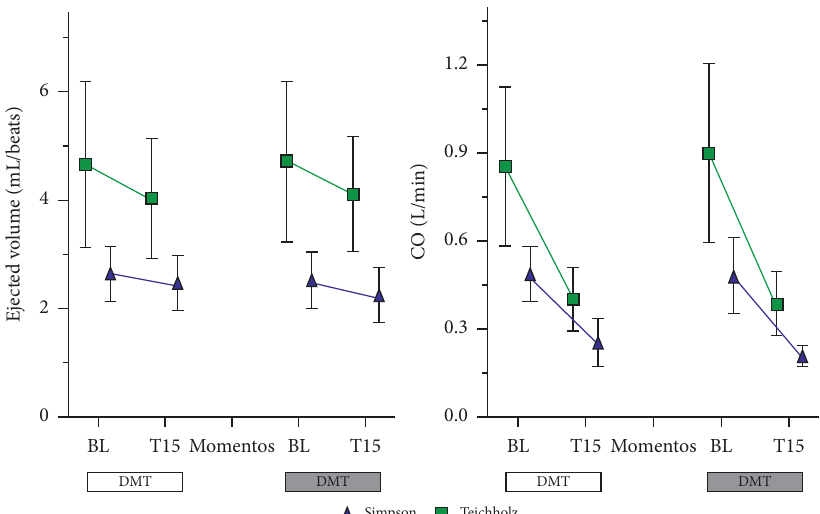
Figure 7: Values of stroke volume (ejected volume) and cardiac output (CO), obtained by the Simpson and Teichholz methods, in 18 cats sedated with the association of dexmedetomidine (7.5ug/kg) and methadone (0.3mg/kg) (DMT, n � 9) or dexmedetomidine (5ug/kg), methadone (0.3mg/kg), and midazolam (0.3mg/kg) (DMTM, n � 9), both by the intramuscular route. Values are presented as mean- ± standard deviation.